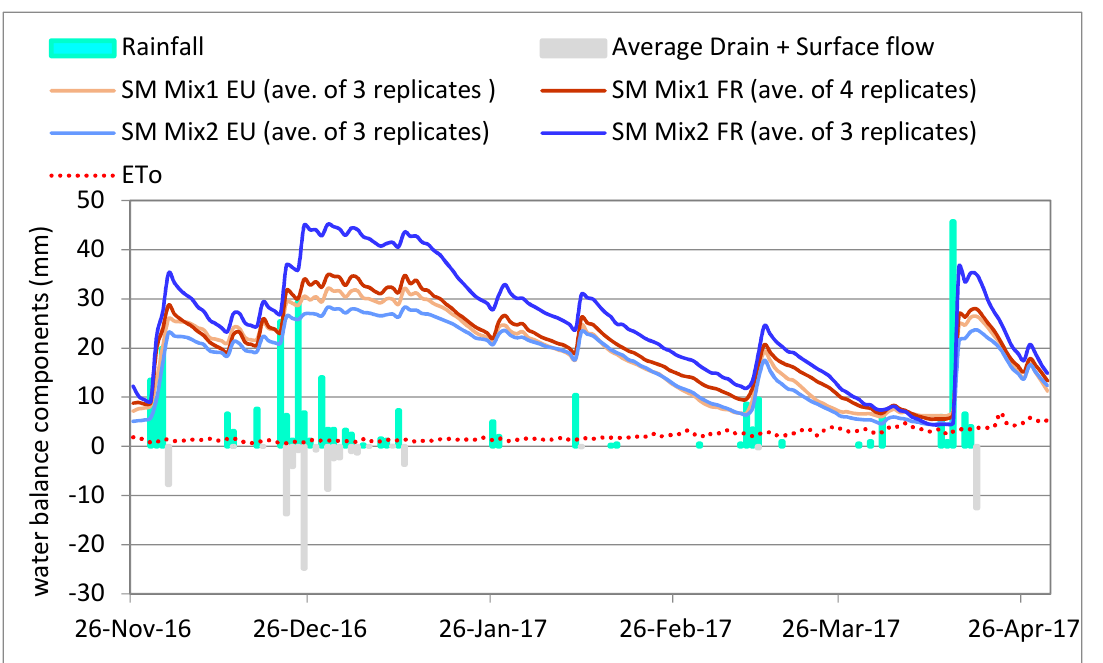
Figure 2. Water balance components and soil moisture (SM) for four green roof treatments, consisting of two substrate mixtures (Mix1, Mix2) and two plant species (EU = E. veneris , FR = F. Laevis ) from 26 November 2016 to April 2017.